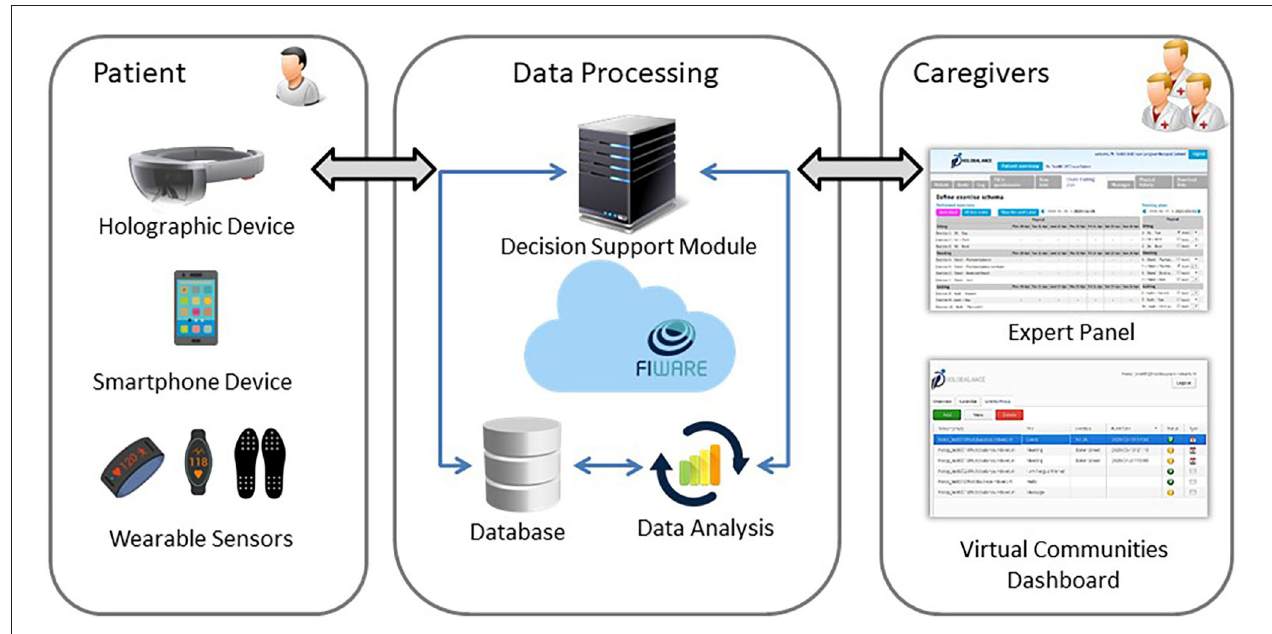
FIGURE 1 | Outline of HOLOBALANCE